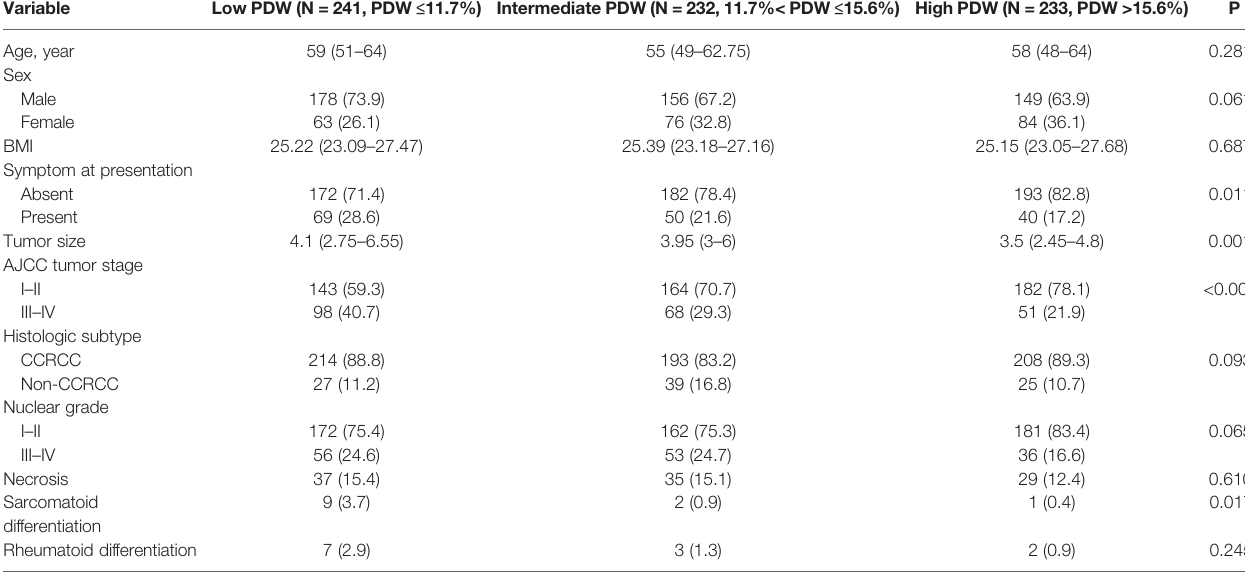
TABLE 2 | Relationship between platelet distribution width and clinicopathologic characteristics.